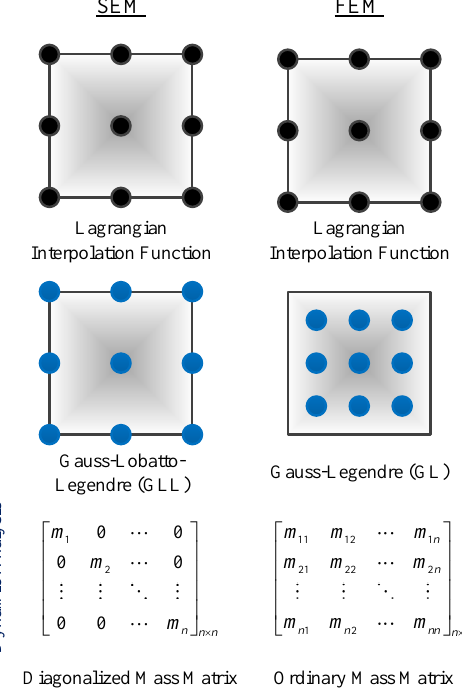
Figure 1. Fundamental differences between the spectral element method (SEM) and FEM.